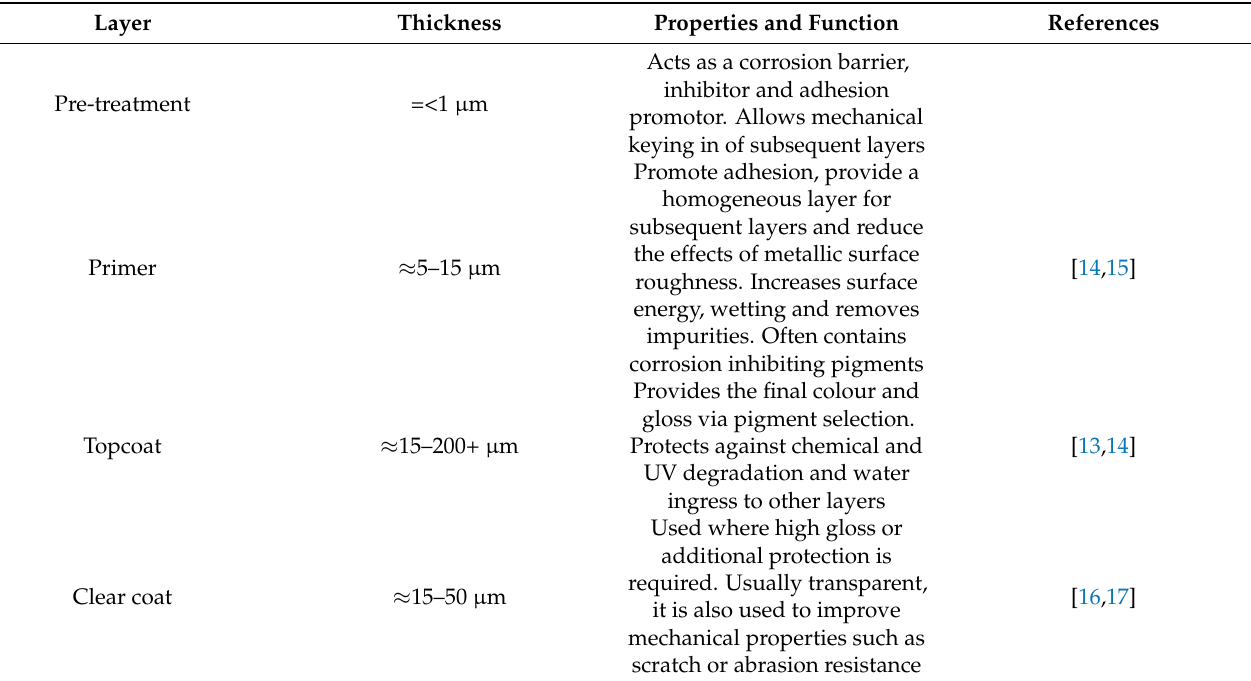
Table 2. Coating